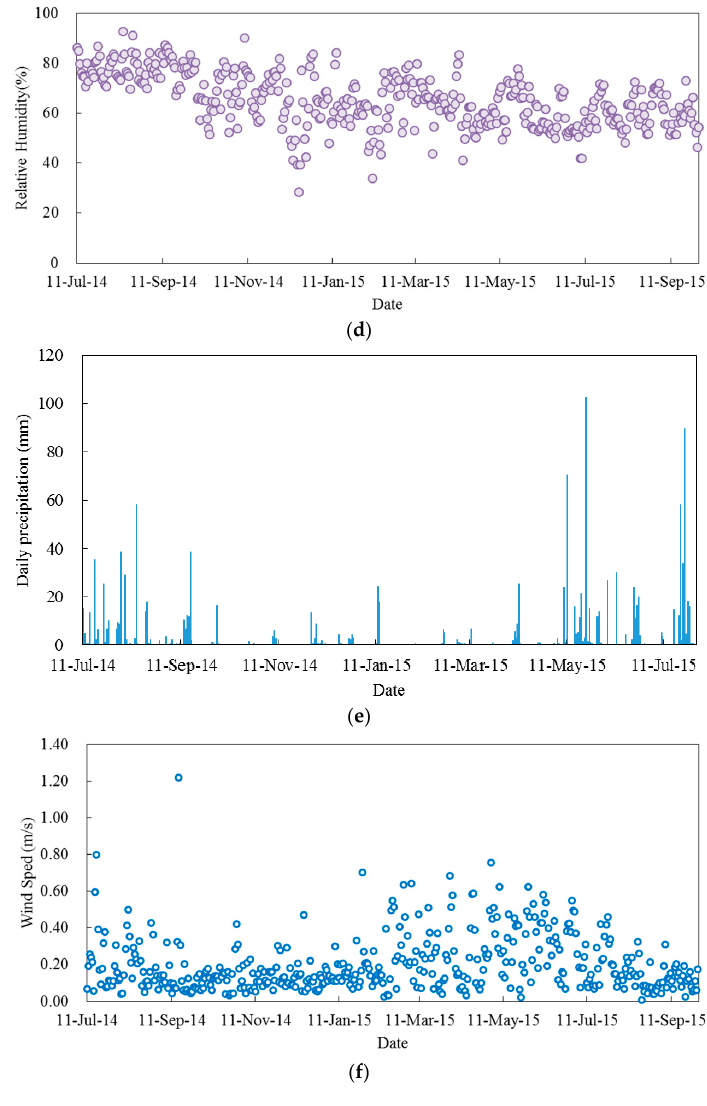
Figure 2. ( a – f ) Daily mean value of solar radiation (R s ), net radiation (R n ), photosynthetic active radiation (PAR), air temperature, relative humidity, precipitation, and wind velocity over the period (from 11 July 2014 to 30 September 2015) in the experimental site. The daily maximum R n was 199.04 W m − 2 (on 27 July 2015), whereas the minimum value of R n was − 32.50 W m − 2 (on 17 December 2014). From 1 August 2014 to 31 July 2015, the daily average R n was 78.34 W m − 2 . The average monthly R n varied from 30.16 to 134.23 W m − 2 . The maximum appeared in June, and the minimum appeared in December. R n was significantly higher in the summer period (June, July, and August) than in the other seasons. PAR showed a similar trend as R s , being higher in summer and autumn, lower in spring and summer. The daily maximum PAR was 1197.66 µmol m − 2 s − 1 (on 16 June 2015), and the minimum value was 125.76 µmol m − 2 s − 1 (on 27 December 2014). The average monthly PAR was in the range of 410.66 to 825.46 µmol m − 2 s − 1 . The annual daily average PAR was 629.16 µmol m − 2 s − 1 from 1 August